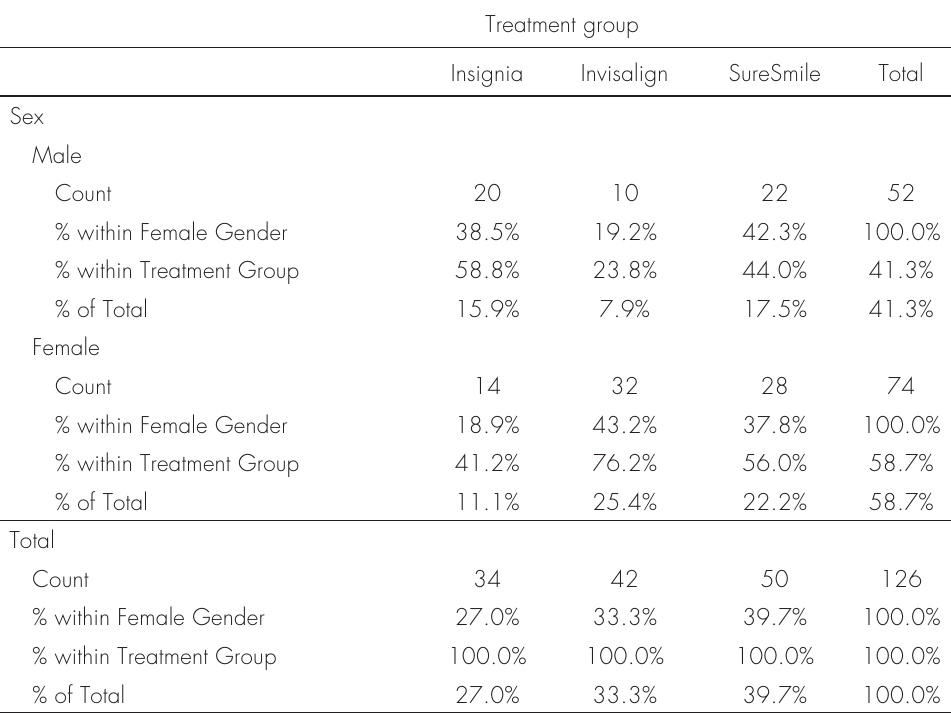
Table X. Gender and Treatment Group Crosstabulation for arches used for objective grading